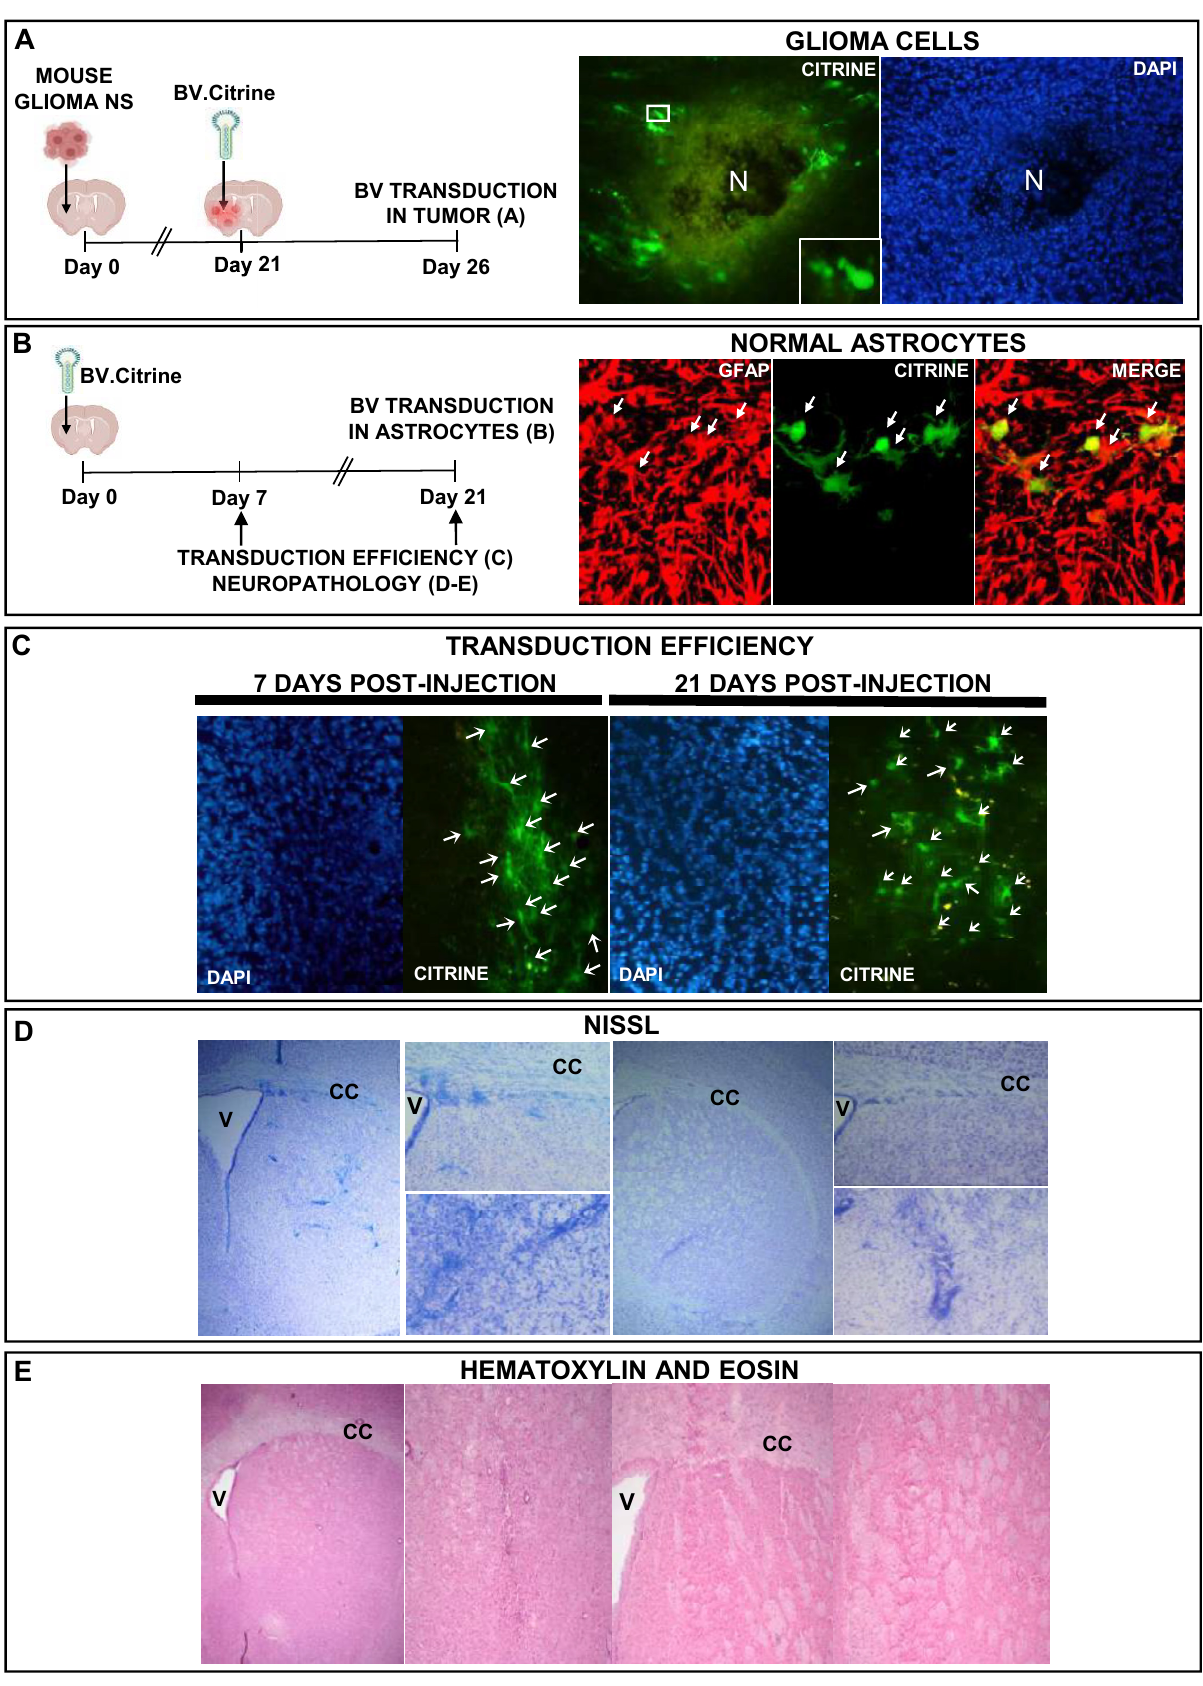
FIG. 6. BV- MEDIATED TRANSGENE EXPRESSION IN NORMAL AND NEOPLASTIC ASTROCYTES IN VIVO